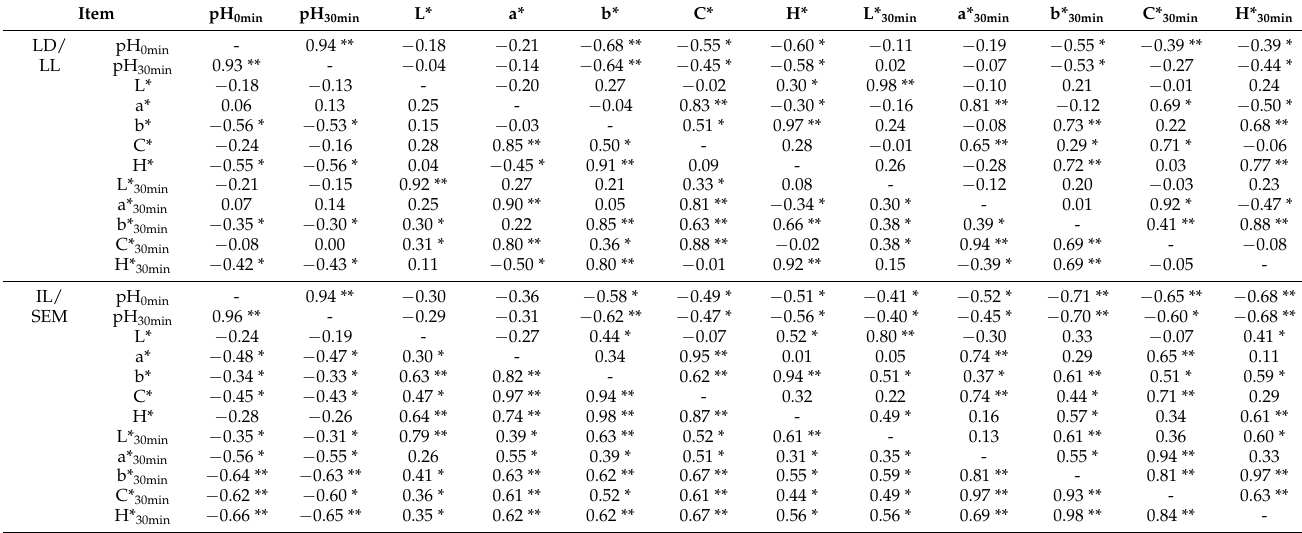
Figure 3. Dependences of percentage color change and pH during 30 min bloom time. The correlation coefficients for pH and color parameters for the individual muscle types at 0 min and 30 min bloom time are presented in Table 2. Numerous correlation coefficients were observed at moderate and strong levels, which were statistically confirmed ( p ≤ 0.05, p ≤ 0.01). The lowest number of such correlations was noted for LD and CT muscles, and the highest for SEM. Table 2. Correlation coefficients between pH and color parameters at 0 min and 30 min bloom time for each muscle